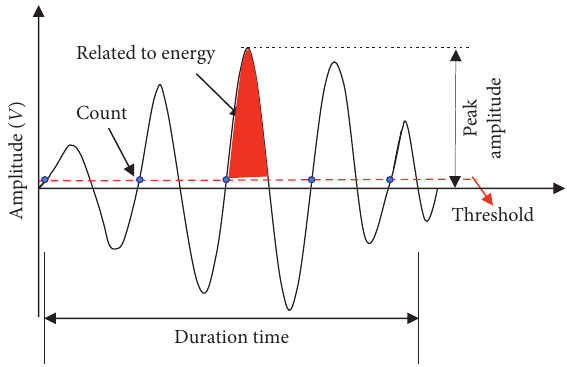
Figure 1: Parameters of typical AE signal